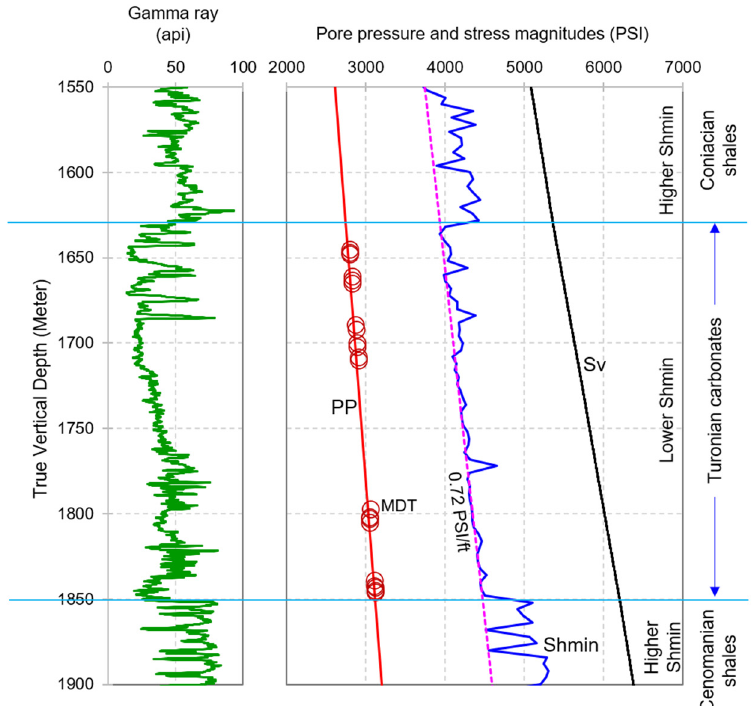
Figure 7. Estimated pore pressure, vertical stress (Sv), and minimum horizontal stress (Shmin) mag- nitudes in the Turonian carbonates, overburden (Coniancian shales), and under burden (Cenomanian shales), please refer to Baouche et al. [9] for details. Data belongs to Well-1.